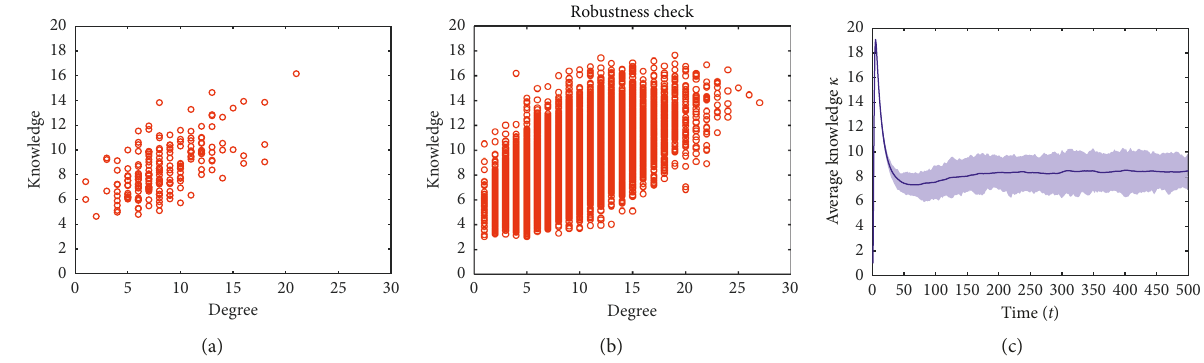
Figure 6: Evolution result when the initial R&D network structure is a BA scale-free network ( p � 0 .